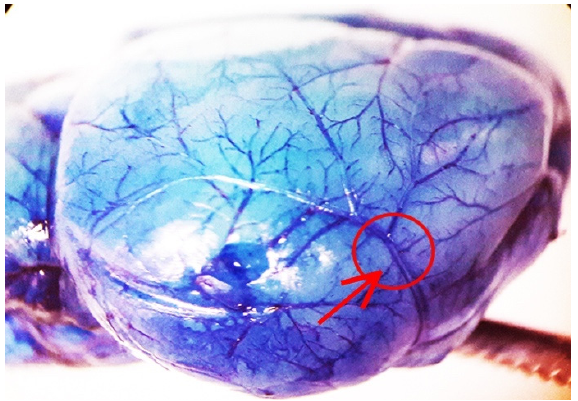
Figure 1. Representative image of electrocoagulation model of permanent focal ischemia obtained following Blue Evans perfusion of a sham-operated mouse.